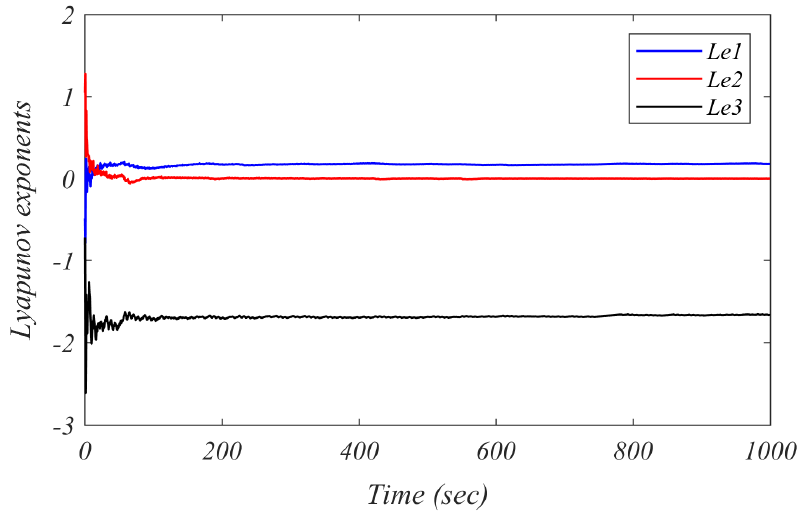
Figure 11. The system (14) Lyapunov exponents versus the time. Where, Le1 = 0.182613, Le2 = 0.000821, and Le3 = − 1.664100 are the consistent Lya- punov exponents obtained. The presence of positive Lyapunov exponent ( Le1 and Le2 ) suf- fices to establish that the system (14) is capable of exhibiting chaos. Additionally, Lyapunov exponents are considered with respect to varying the system fractional order to q ∈ [0.8, 1] as displayed in Figure 12. The Lyapunov exponents are Le1 = 0.1636, Le2 = 0.1042, and Le3 = 0.5025, as shown in Figures 11 and 12, indicating a chaotic exhibition by the proposed system. In plotting both Figures 11 and 12, the used system parameters, initial conditions, and fractional order ( q ) are selected as illustrated in Table